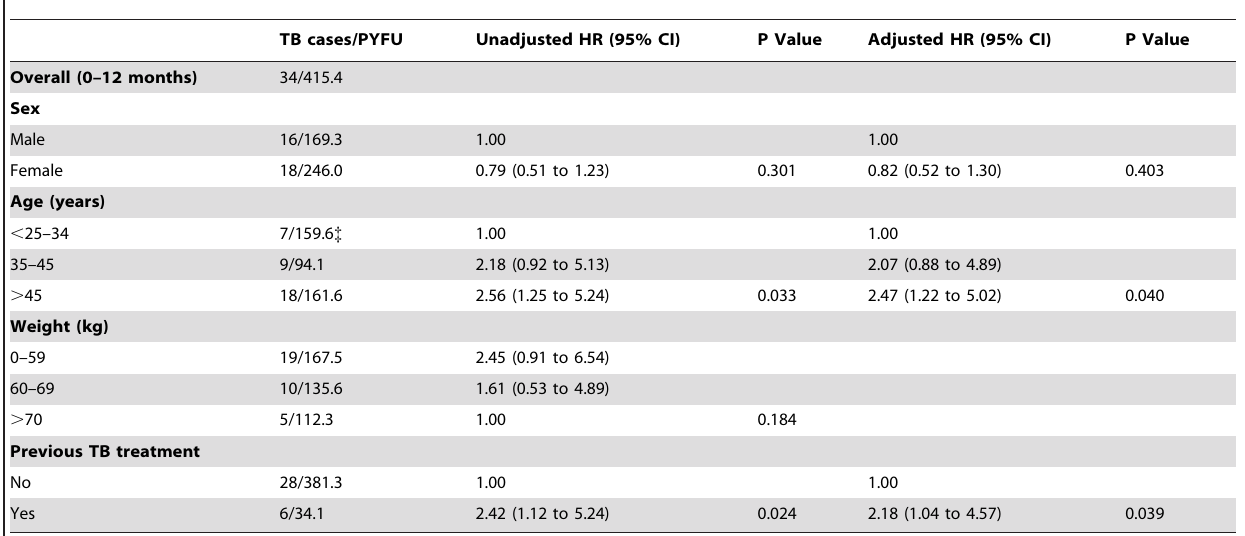
Table 4. Univariable and multivariable analysis of risk factors associated with TB diagnosis in HIV-negative